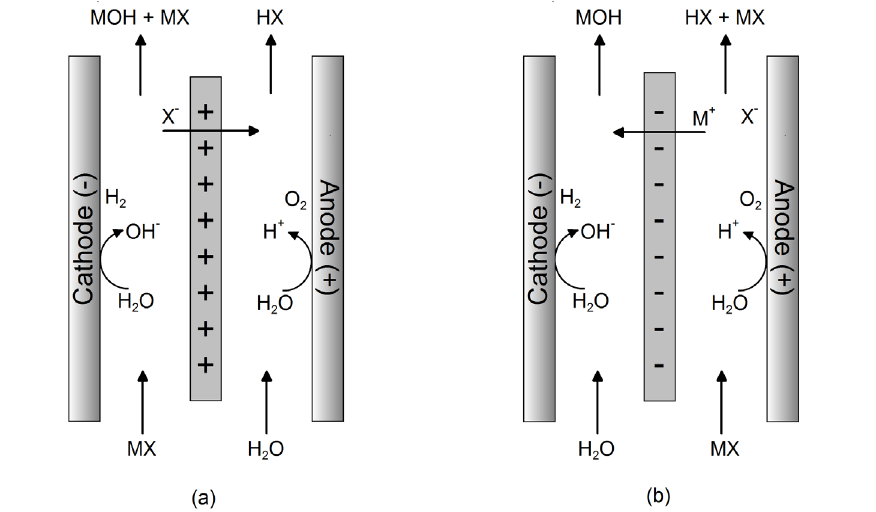
Figure 1: Schematic representation of membrane electrolysis with anion-exchange membrane (a) or cation-exchange membrane